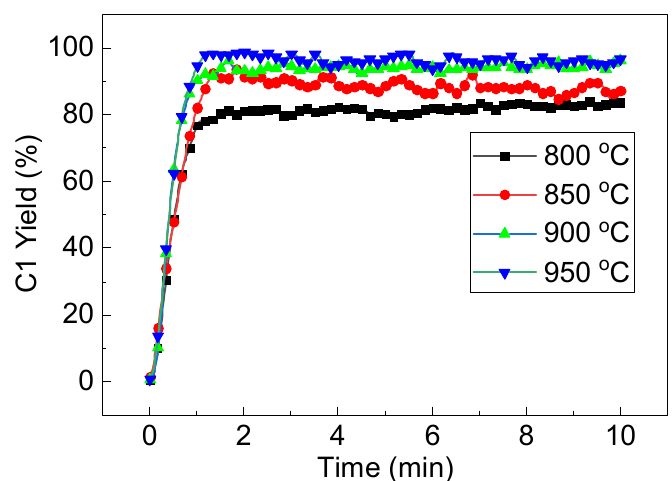
Figure 12. Effect of S/C ratio on the yield of C 1 , Coke and H 2 at 900 °C using LaFe 0.6 Ni 0.4 .